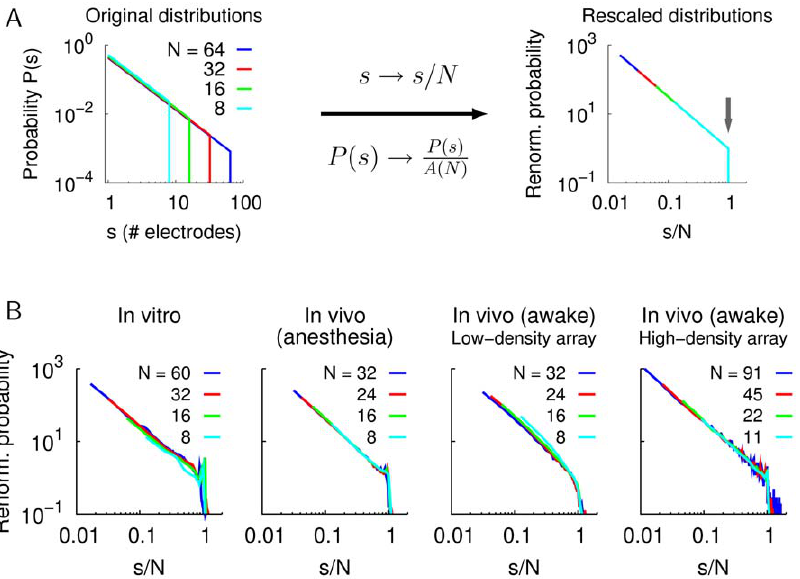
Figure 2. Collapse of rescaled cluster size distributions in neuronal avalanches. A. Depiction of the rescaling approach for synthetic PMFs for maximum sizes N =8, 16, 32, 64 (left). The system size, N , corresponds to the number of electrodes included in the analysis. Cluster sizes s were normalized by the system size N ( s ? s / N ) and the renormalized probability was obtained according to P ( s ) ? P ( s )/ A ( N ), resulting in a collapse of the cluster size distributions (right). Here, the definition of A ( N ) with upper bound N was used (Eq. 16). The vertical arrow indicates the system size (scaled to unity). B. Collapse of rescaled cluster size distributions for average in vitro distributions ( n =7), average in vivo distributions under anesthesia (rat, n =7), and the two awake monkeys with low- and high-density array, respectively (from left to right). Note that the maximum cluster size for all data sets increases with N with the distribution showing a clear cut-off beyond the system size ( s / N =1). The exponent a for the empirical distributions was fitted individually for each system size N (see Materials and Methods